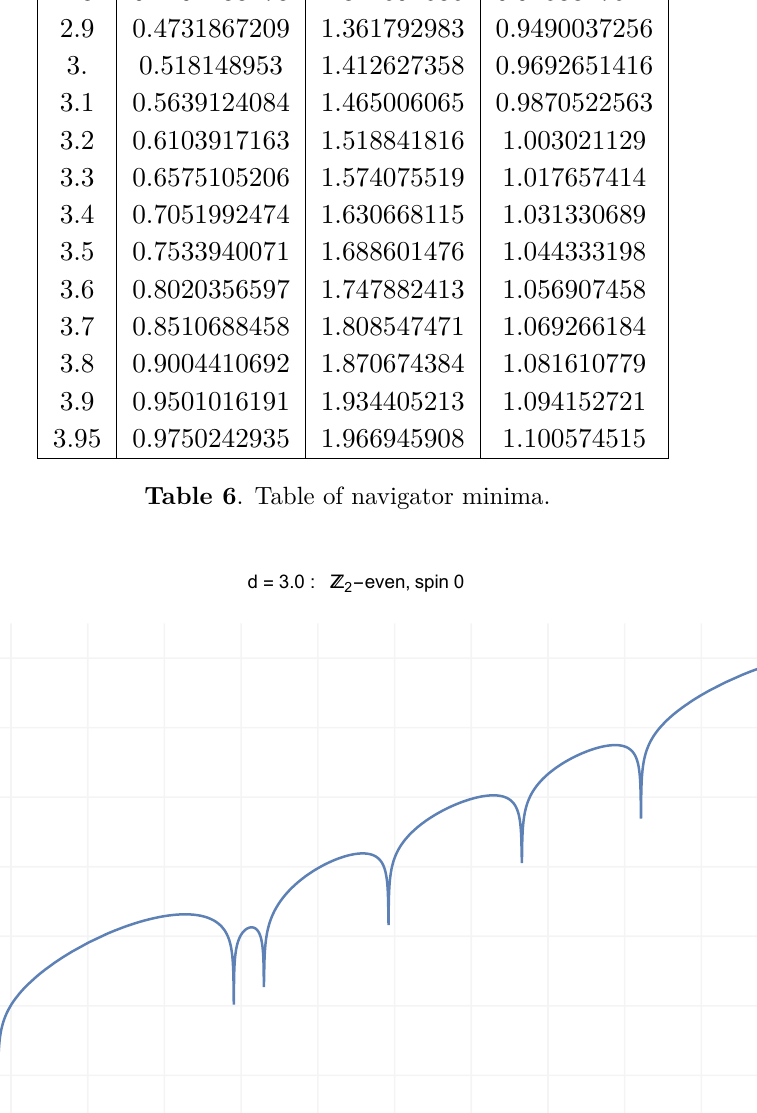
From figure 21 we read off the following